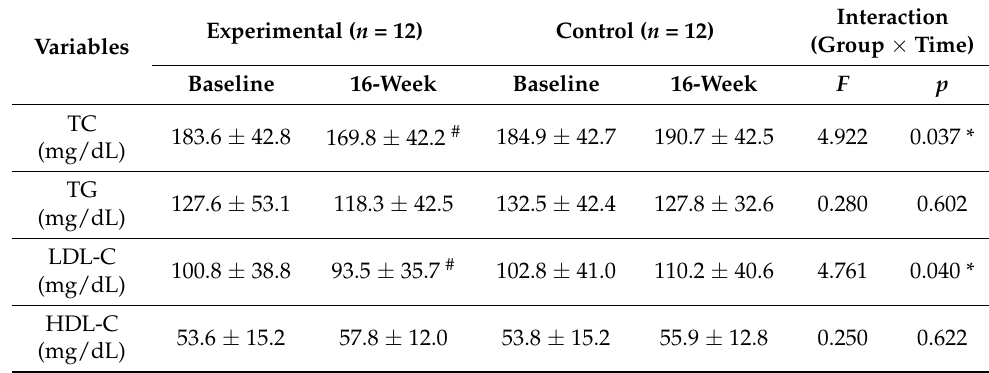
Table 3. Changes in lipid profiles.